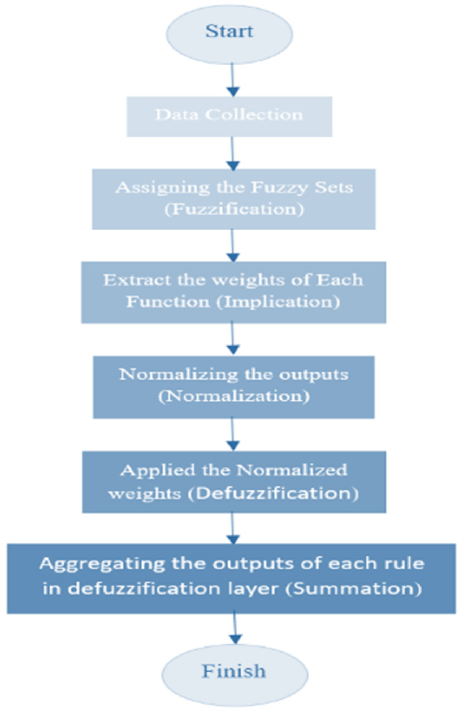
Figure 3. The structure of the ANFIS model.